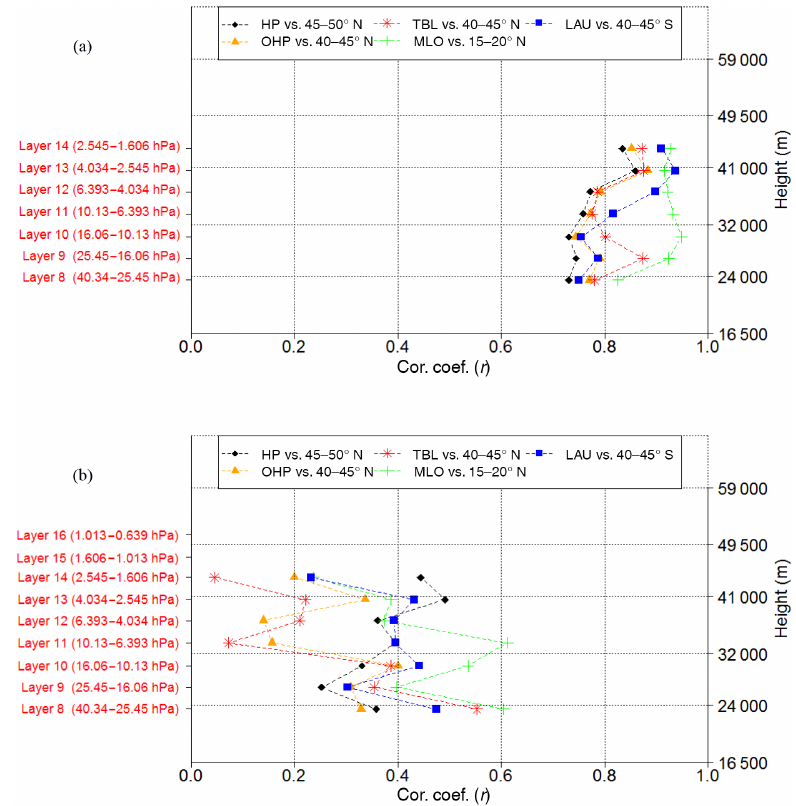
Figure 2. (a) Correlations between monthly mean SBUV station overpasses and the corresponding SBUV monthly 5 ◦ zonal means. (b) Correlations between monthly mean lidar observations and the corresponding SBUV monthly 5 ◦ zonal